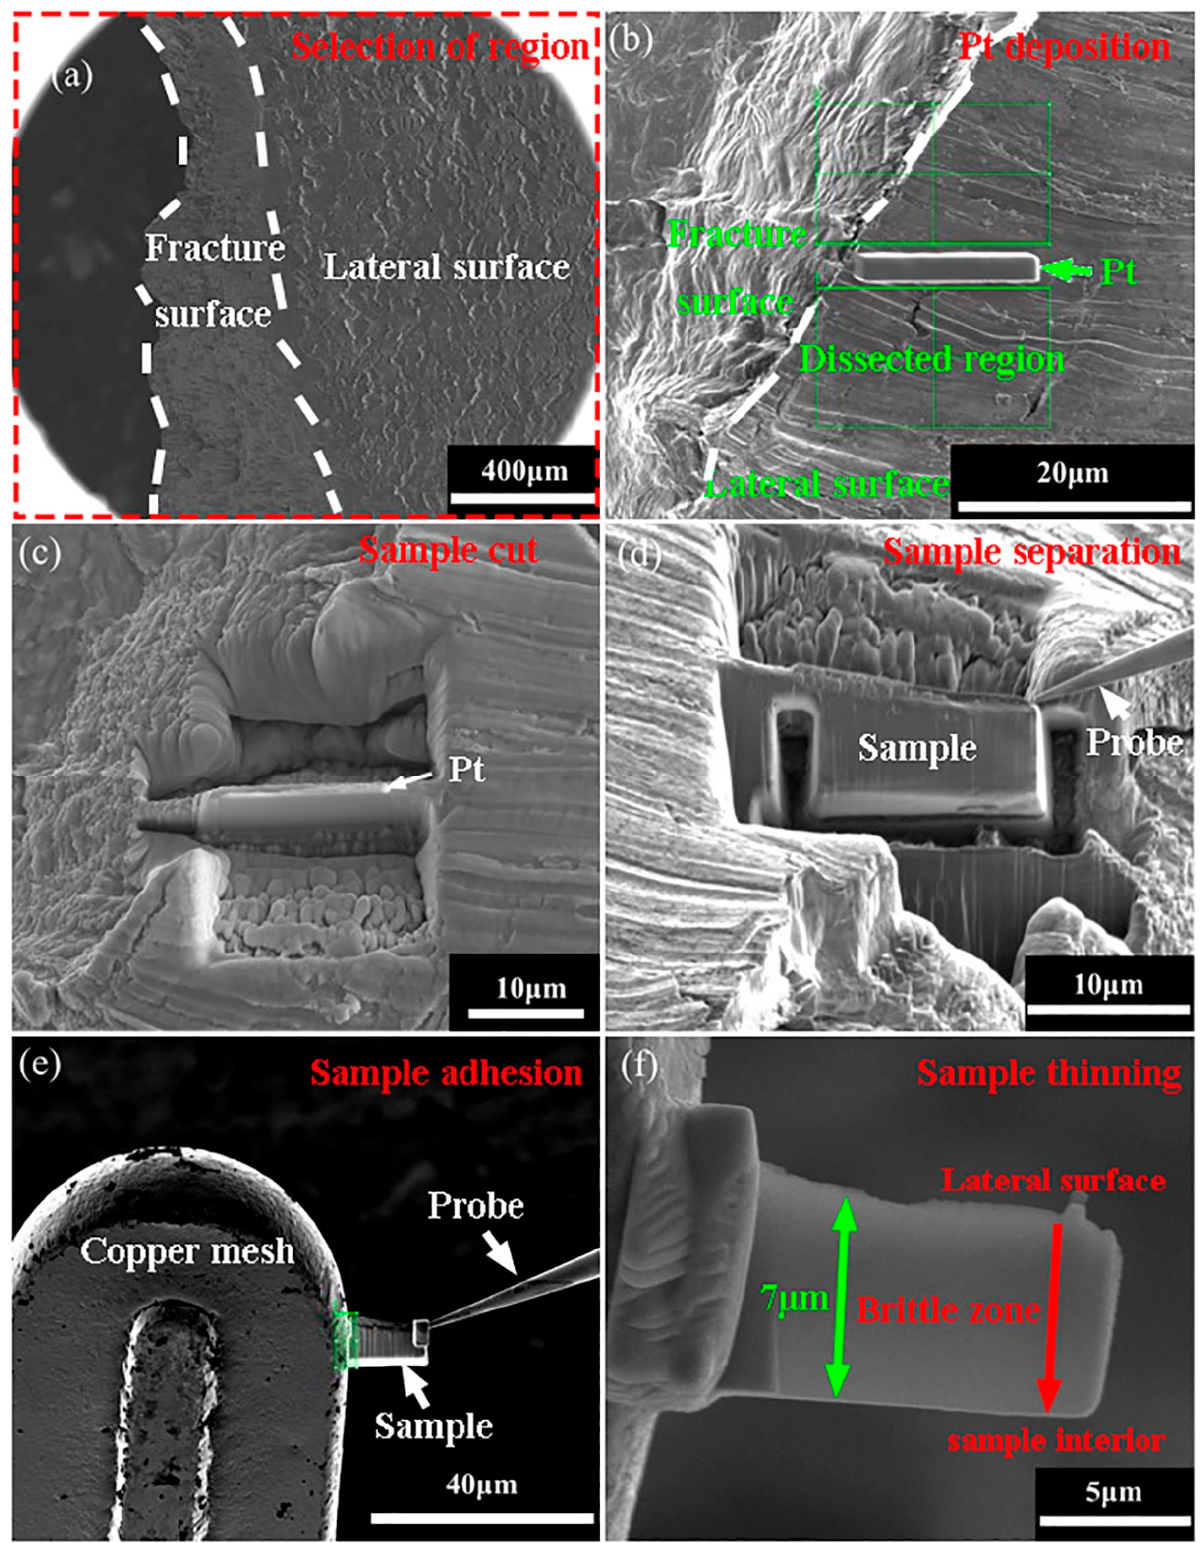
Figure 7. A representation of the preparation processes of hydrogen-charged TEM foil sample. ( a ) Selection of target region; ( b ) Pt layer deposition; ( c ) Cutting of the sample; ( d ) Sample separation; ( e ) Sample adhesion; ( f ) Ion thinning.